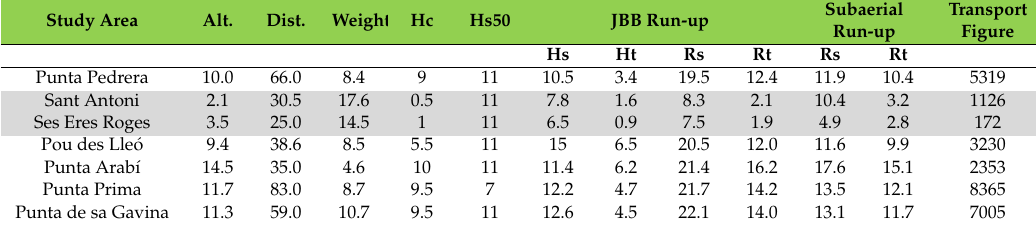
Table 4. Main characteristics of the boulders with TF > 1000 from the di ff erent study areas. (Alt., average altitude of the boulders, Dist., the average distance from the cli ff edge, JBB, joint bounded boulders, Rs—run-up for storm waves, Rt, run-up for the tsunami). In grey, locations dominated by storm-waves action. Study Area Alt. Dist. Weight Hc Hs50 JBB Run-up Punta